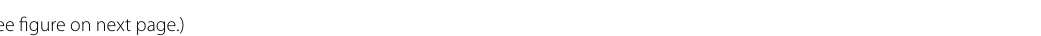
(See figure on next page.) Fig. 2 Schematic representation of the artificial neural network (ANN) model. This model consists of 7 input neurons [age, Charlson comorbidity index (CCI), chemotherapy, radiotherapy, hormone therapy, surgery volumes of hospital and surgeon], 1 bias neuron in the input layer, 4 neurons in a single hidden layer (H1‑4), 1 bias neuron in the hidden layer (HB), and 2 output neurons (death and survival) representing the 5‑year outcome of breast cancer patients after surgery. Surgery volume of hospital/surgeon was defined as the percentage of breast cancer surgeries among the total surgeries performed by the respective hospital or surgeon during the study